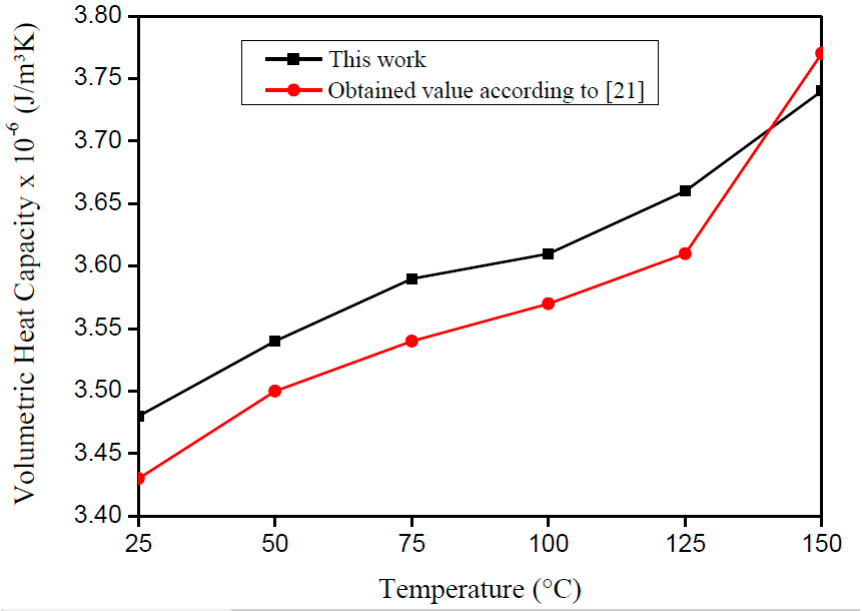
Figure 8. Comparison between the literature values with the estimated results of ρ c p on the AISI 1045 steel plate.